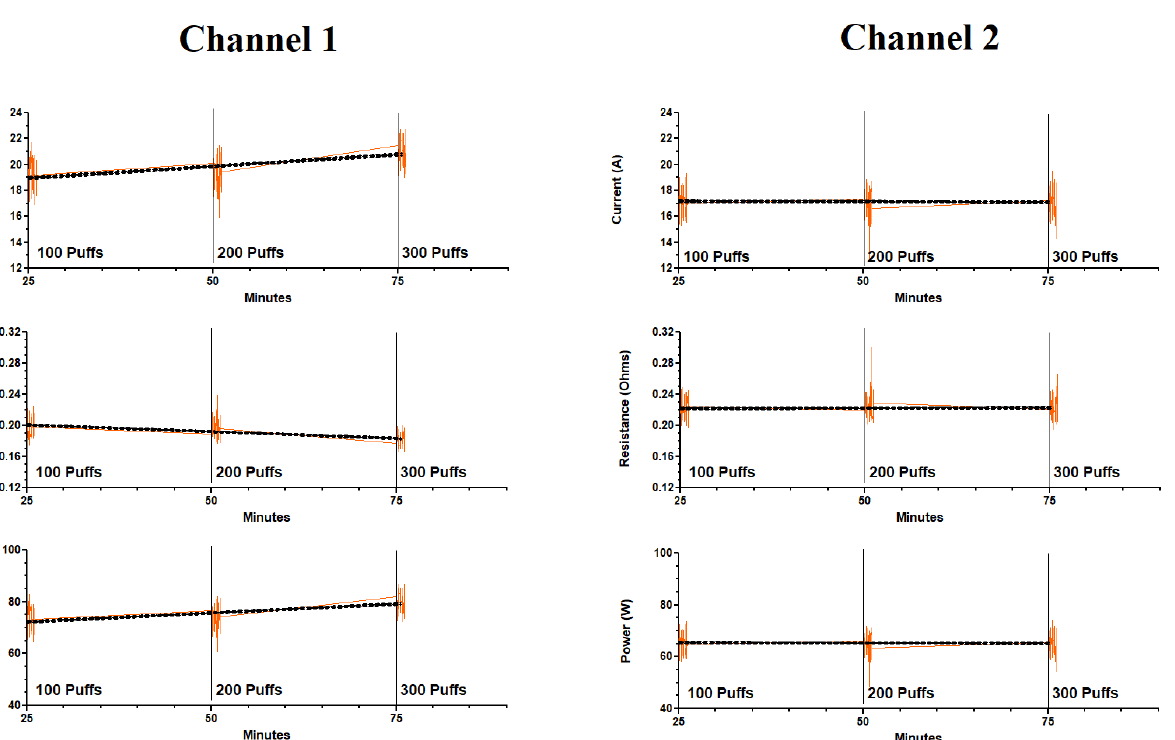
Figure 6. Electrical parameter profiles during 300 continuous puffs of the ECIG aerosol generator running both channels simultaneously. Dashed line represents the trend line for each parameter.